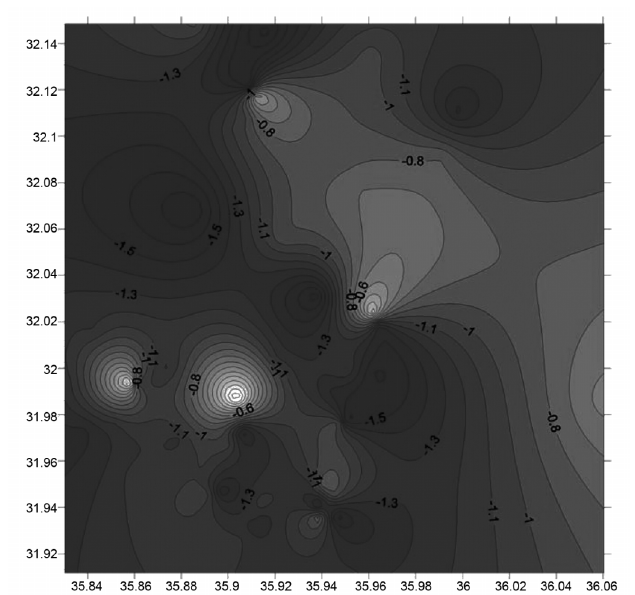
Fig. 7. Differences in meters, between Experimental Undulation (GPS/Levelling data) and gravimetric Jor- dananian Geoid Model (GeoJordan) before fitting (latitude and longitude in WGS84).